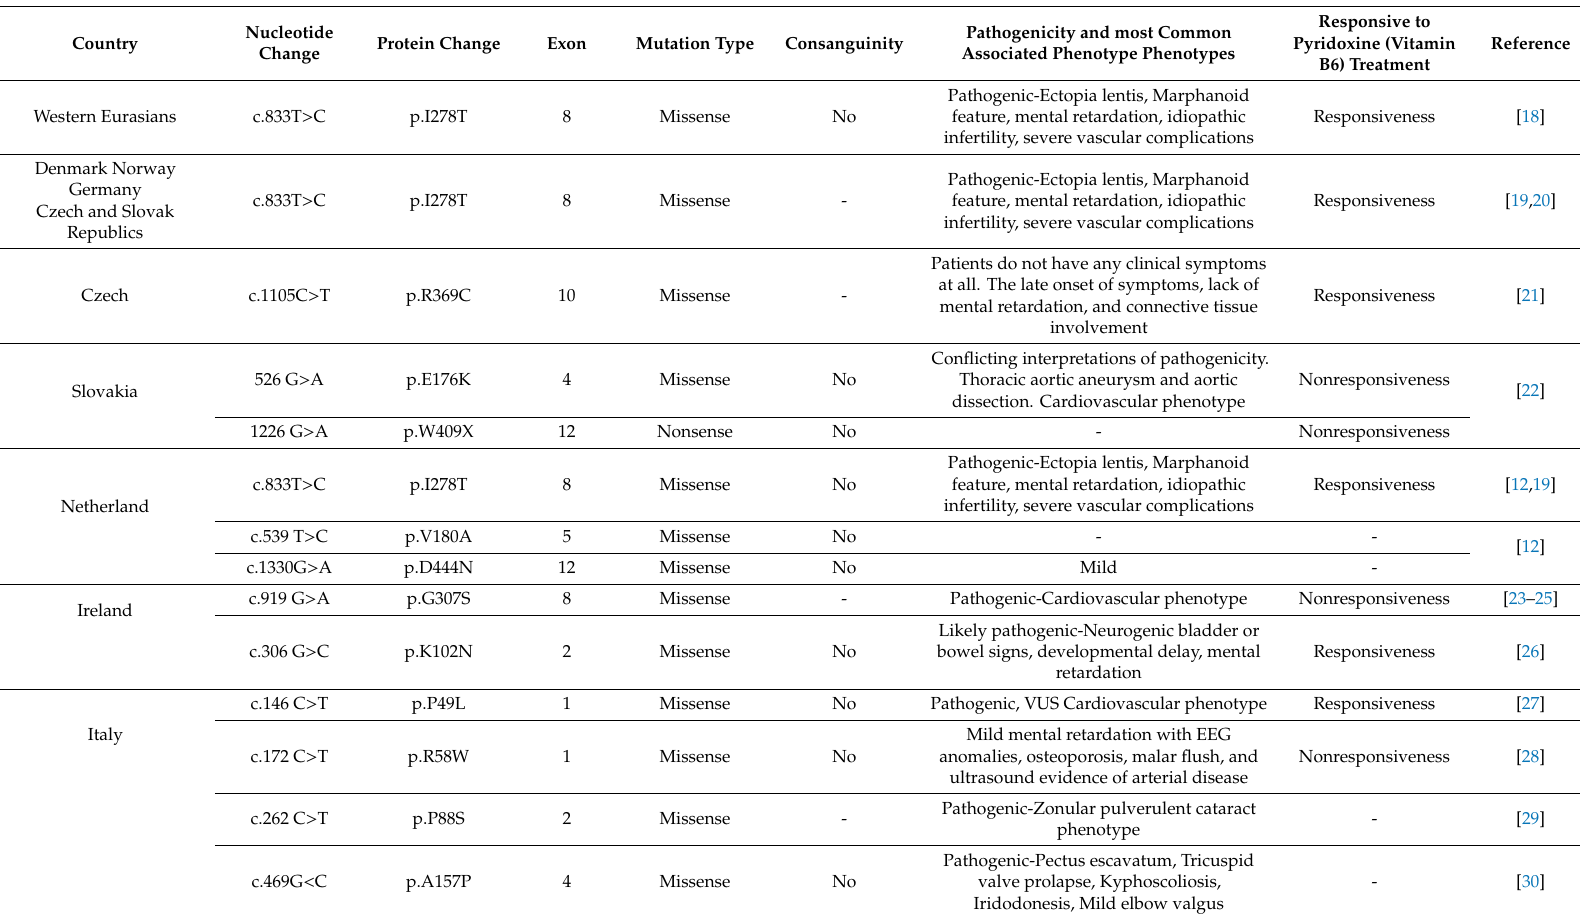
Table 1. Cystathionine beta-synthase ( CBS) mutations and clinical phenotypes of homocystinuria reported